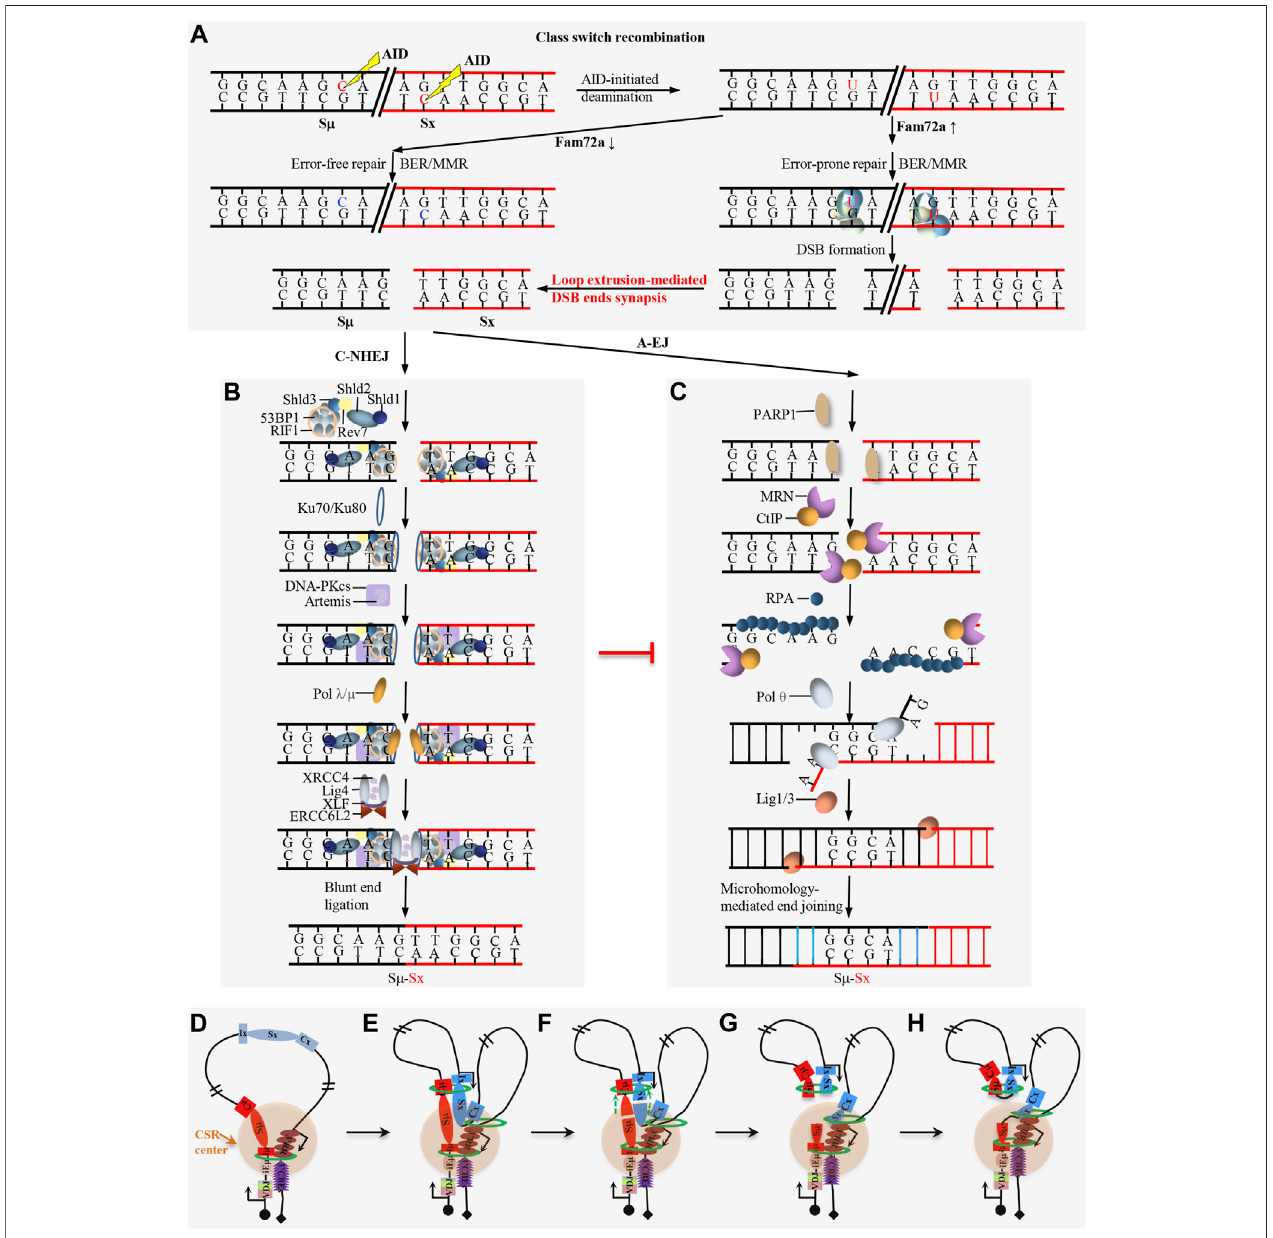
FIGURE 4 | Overview of DNA damage repair process during CSR. (A) FAM72a regulates the error-prone vs. error-free DNA repair during AID-initiated CSR. AID- initiated breaks are converted into double-strand breaks (DSBs) upon high level of FAM72a during CSR. (B) Overview of the DNA damage response (DDR) factors and C-NHEJinpromotingdirectendjoiningduringCSR. (C) Overviewofthealternativeendjoining(A-EJ)inpromotingDSBendresectionandmicrohomology-mediatedend joining during CSR. (C – H) Loop extrusion-mediated CSR model. Loop extrusion promotes CSR center formation (D) , acceptor S region activation (E) , S μ – Sx synapsis (F) , and deletional end joining (G – H)